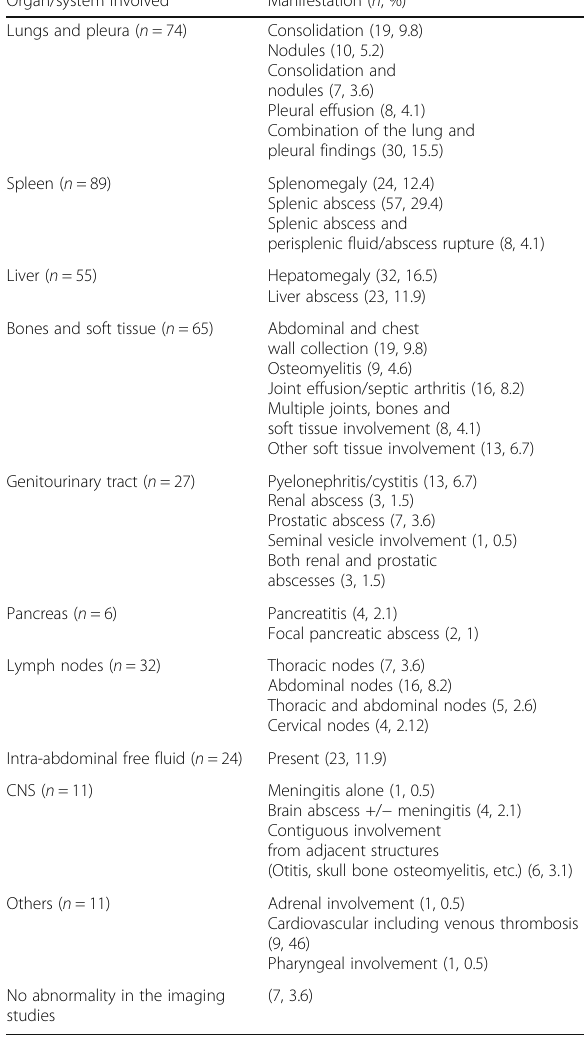
Table 1 Imaging manifestation of various organ/system involvement (mutually